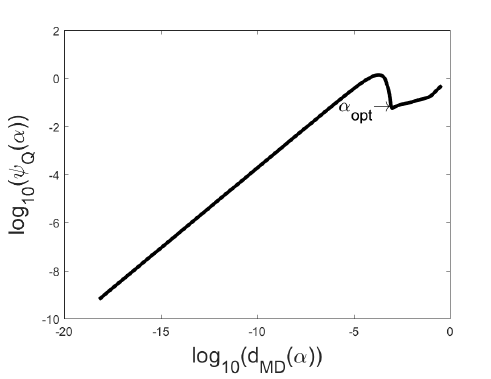
Figure 3. L-curve for Deriv2.